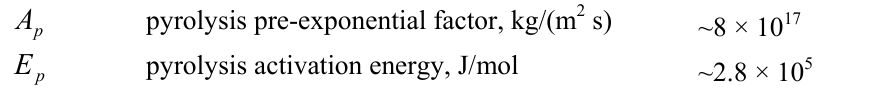
Table 5. Estimated kinetic properties of